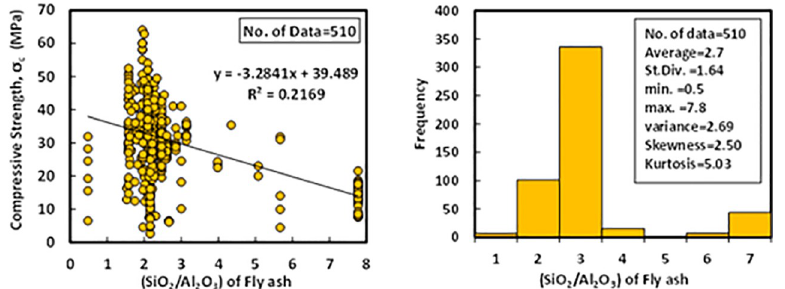
Fig 2. Variation between compressive strength and (SiO 2 /Al 2 O 3 ) ratio of fly ash with the histogram of fly ash- based geopolymer concrete